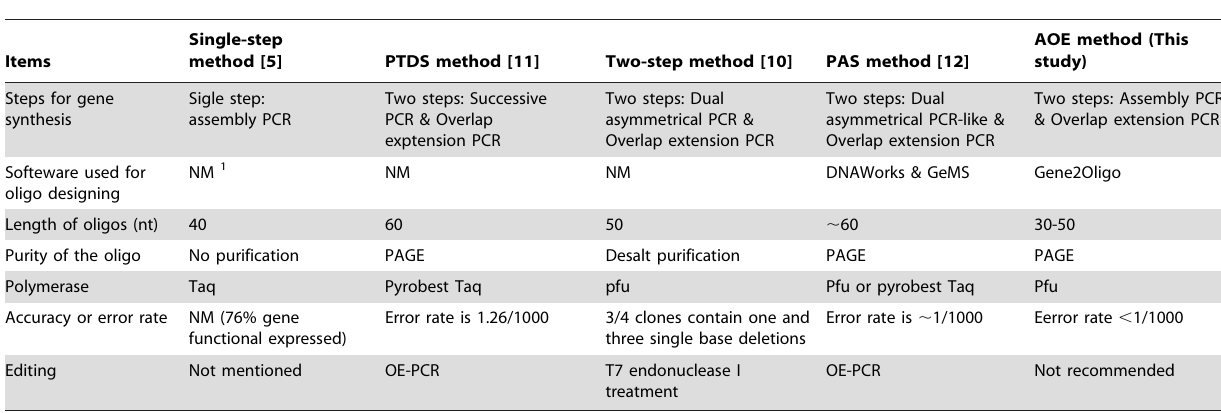
Table 1. Comparison of different methods used for gene